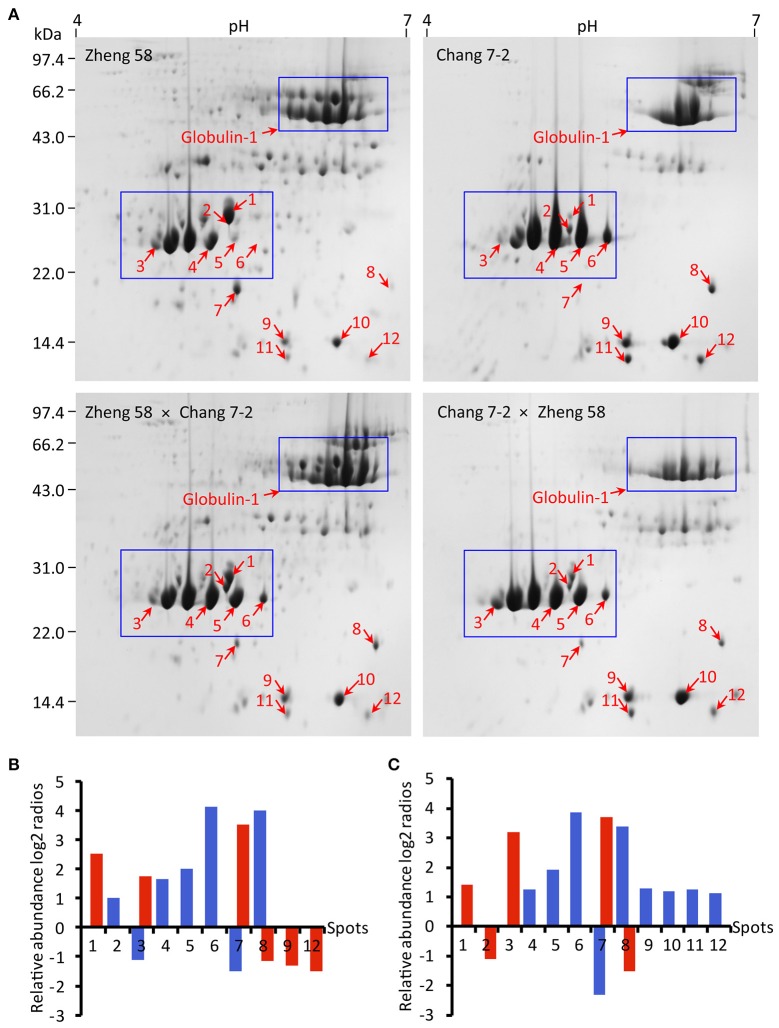
2-DE profiles, abundance, and comparison of SSPs in maize embryos of hybrids and their parents. Maize embryo SSPs (600 μg) were resolved by IEF using 11 cm pH 4–7 IPG dry Strip. Secondary SDS-PAGE was carried out on a 12.5% resolving gel. (A) Spots of relatively abundant protein in hybrids and their parents with at least two-folds change in abundance are indicated with red arrows. Blue boxes indicate the regions concentrated with differential SSPs. (B,C) Indicating log2 ratios of Zheng 58 × Chang 7-2 and Chang 7-2 × Zheng 58 to their parents blue represents Zheng 58 and red represents Chang 7-2. Log2 ratio > 1 represents more than two-folds of abundance change. Spot volumes were determined using the PDQuest software.